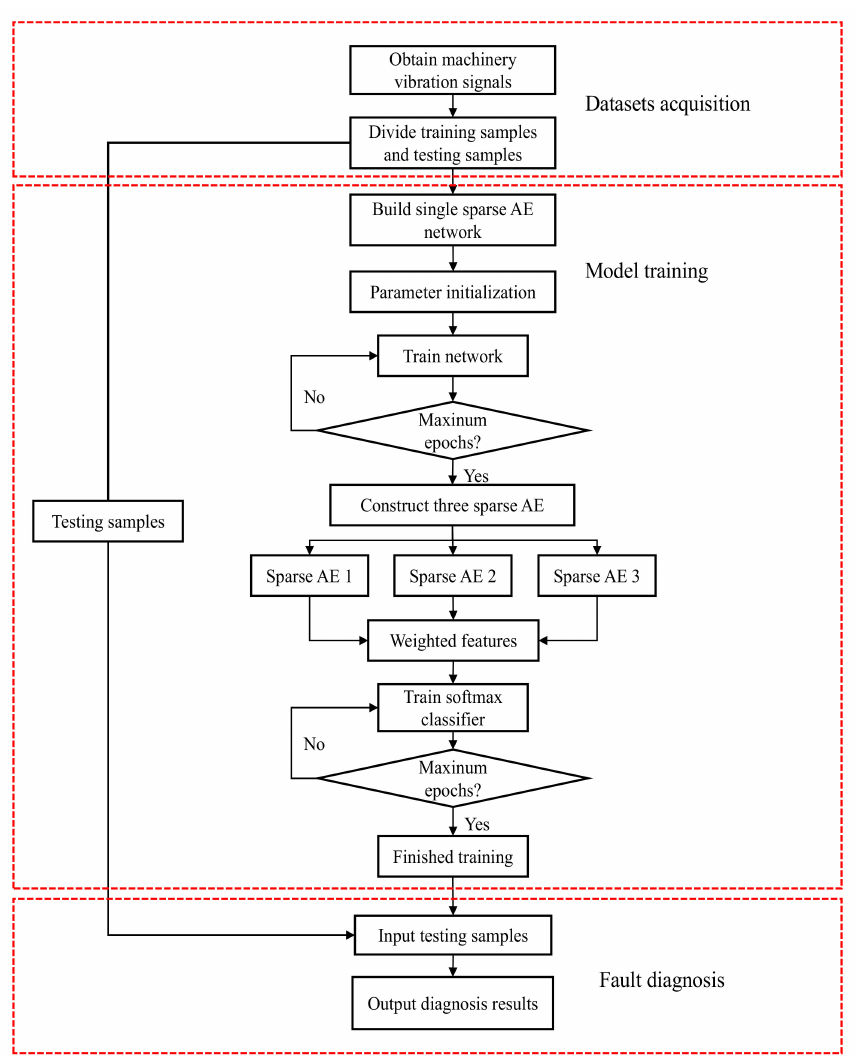
Figure 5. Flow chat of the proposed bearing fault diagnosis